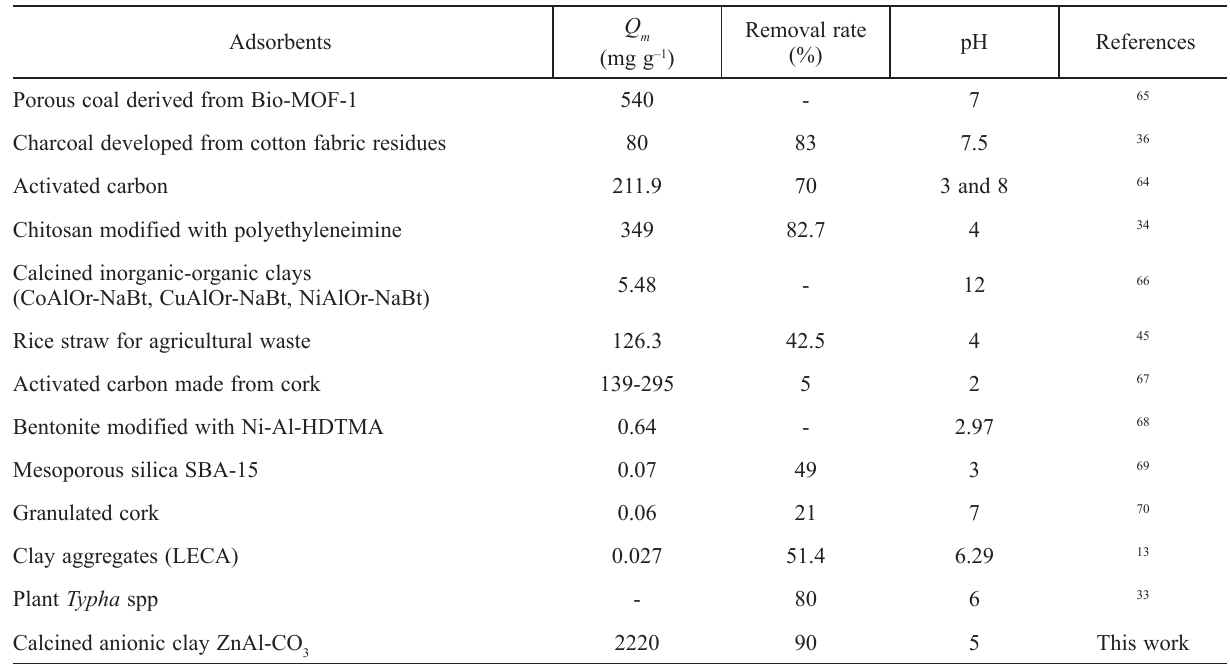
Table 5 – Maximum adsorption capacity and removal rate of CA on different